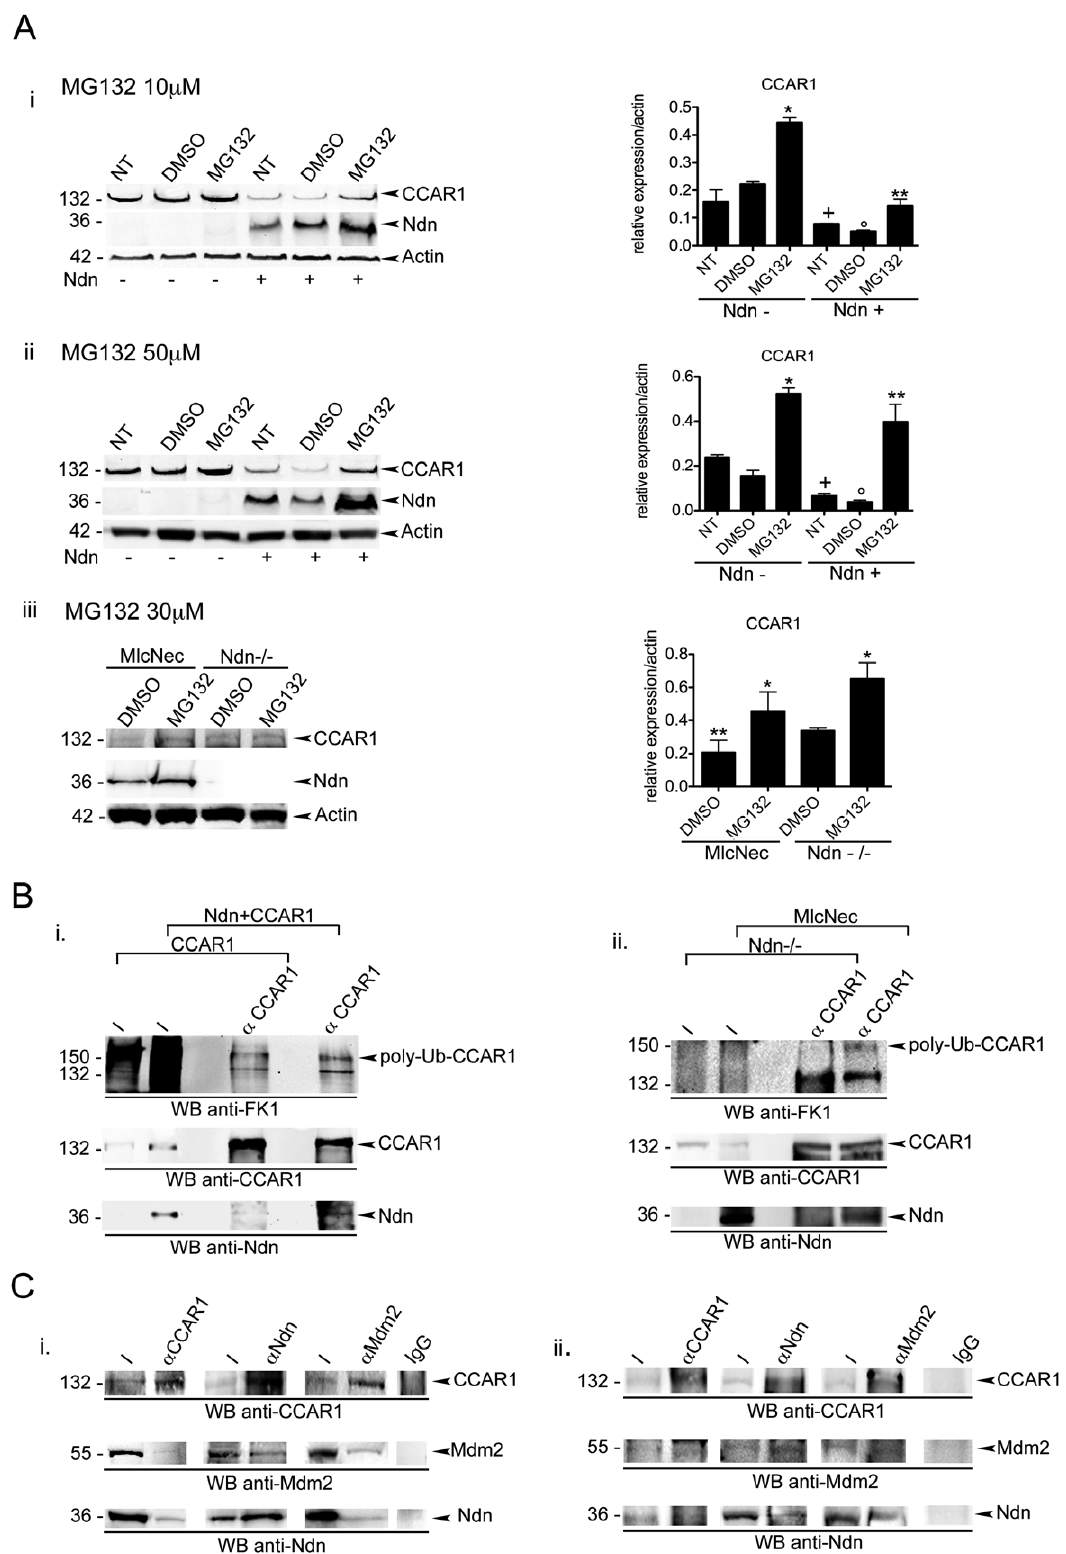
Figure 4. Necdin mediates CCAR1 degradation via the proteasome. A) i–ii Western blot on C2C12 cells not transfected (Ndn-) or transfected with pCMV-FLAG-Necdin (Ndn + ) untreated (NT) or treated with two different concentrations of MG132 (MG132 i: 10 m M; ii: 50 m M) or an equal amount of DMSO as control (DMSO), using antibodies specific for CCAR1, Ndn and b -actin as loading control. Graphs on the right show mean values 6 s.e.m. obtained from the ratio of densitometric values of protein/ b -actin bands on the blot of the same experiments. Data are representative of